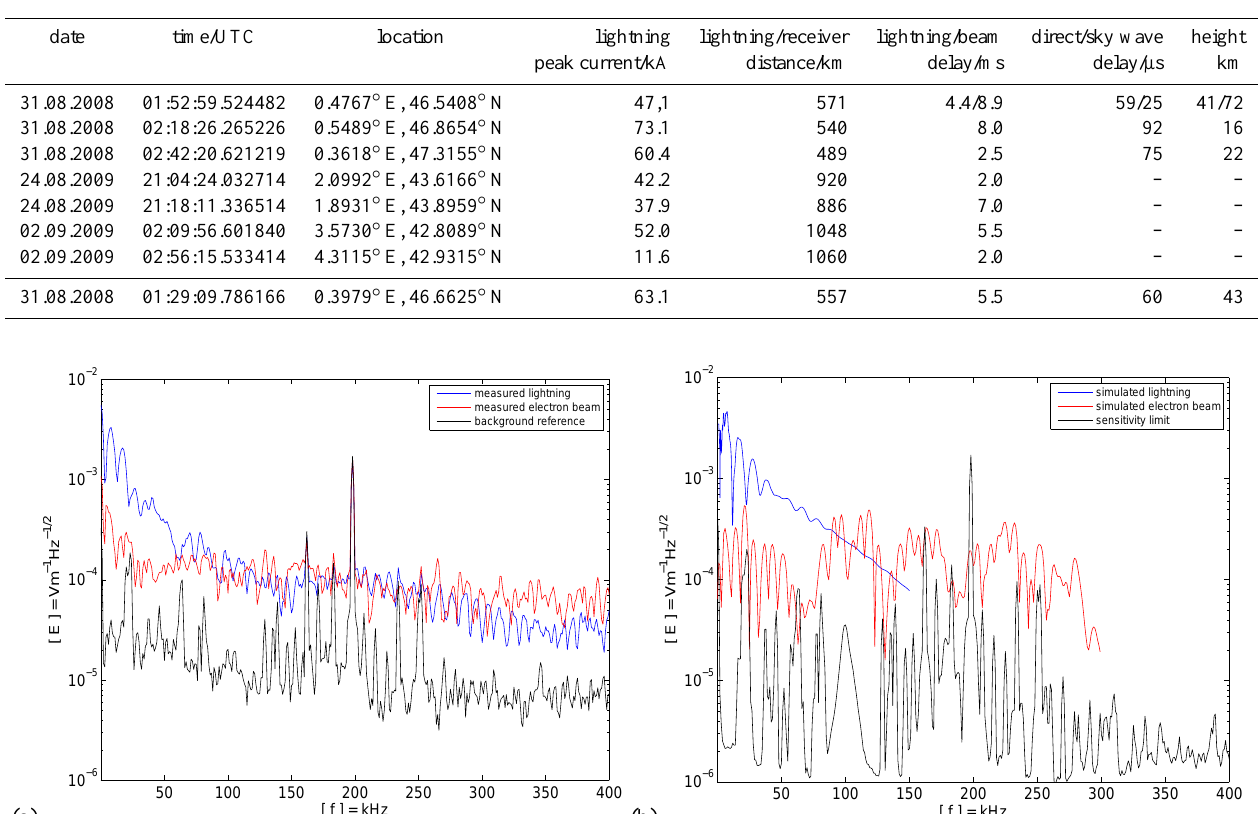
Table 1. Observations of several electron beams associated with sprites. The date, time, and location of the causative lightning discharges are reported by the French lightning detection system M´et´eorage. The distances between the lightning discharges and the wideband digital radio receiver in South-West England vary between ∼ 490–1060km. The electromagnetic radiation bursts from the lightning discharge and the consecutive electron beam exhibit time delays from ∼ 2–9ms. The time delays between the direct wave and the sky wave from the electron beam can only be determined for distances up to ∼ 500km as a result of the larger signal to noise ratio of the electromagnetic recordings. The observed time delays from ∼ 25–92µs indicate that all the electron beams are located at heights between ∼ 16–72km, well above the top of the thundercloud at ∼ 12km (Fig. 1). The last listed event at 01:29UTC on 31 August was not associated with any sprite and it indicates that relativistic electron beams may also occur independently of sprites. The full range of techniques described in the methodology section was used during observations from 00:00–04:00UTC on 31 August 2008.